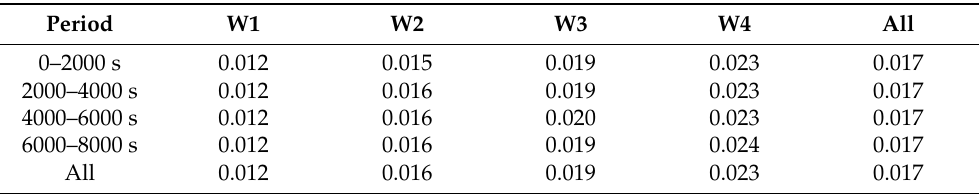
Table A3. Calculated RMSE (m) per 2000 s of iteration, per subsection of target surface in Velodyne ® HDL–32E during 30 m, night experiment. Subsections are labeled W1 through W4, with W1 being the lowest observed and W4 being the highest.